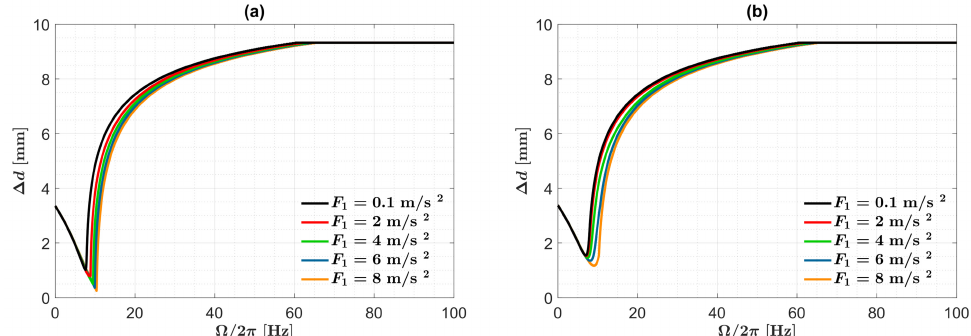
Figure 7. Optimal harvester lengths for five excitation amplitudes under: ( a ) R l = 1 M Ω and ( b ) R l = 188 Ω .